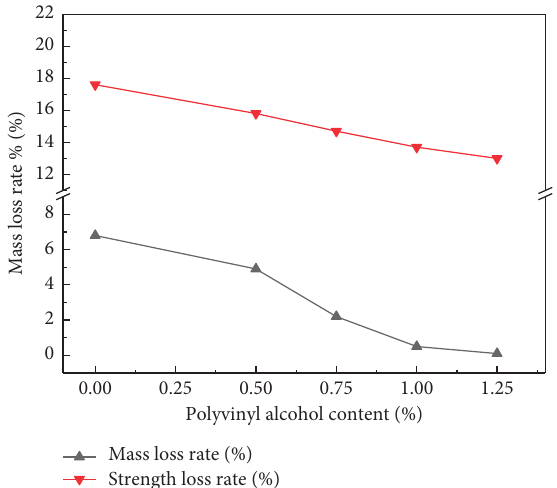
Figure 6: The loss rate of quality and tensile strength after 15 freeze-thaw cycles.